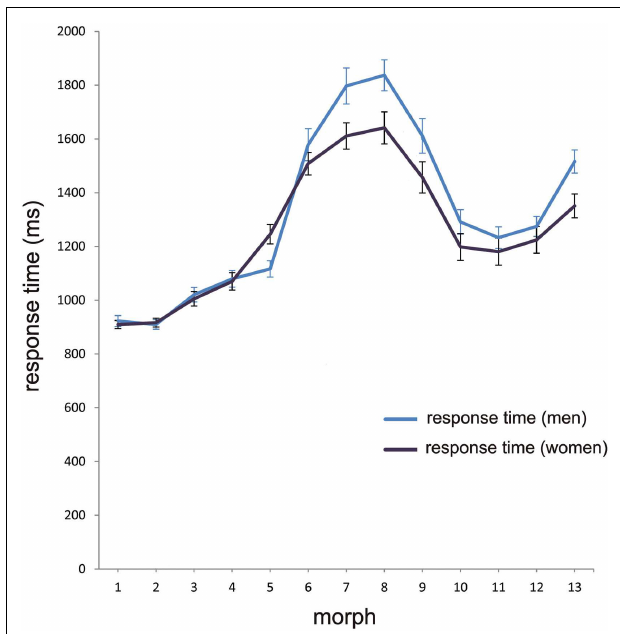
FIGURE 4 | Mean RT in the categorization task. The mean aggregated response time for men (blue line) and women (black line) at the different morph positions 1–13, with error bars as standard errors ( N = 59). Note that the longest response latencies for men and women at morph 8 correspond with the category boundary shown in Figure 2